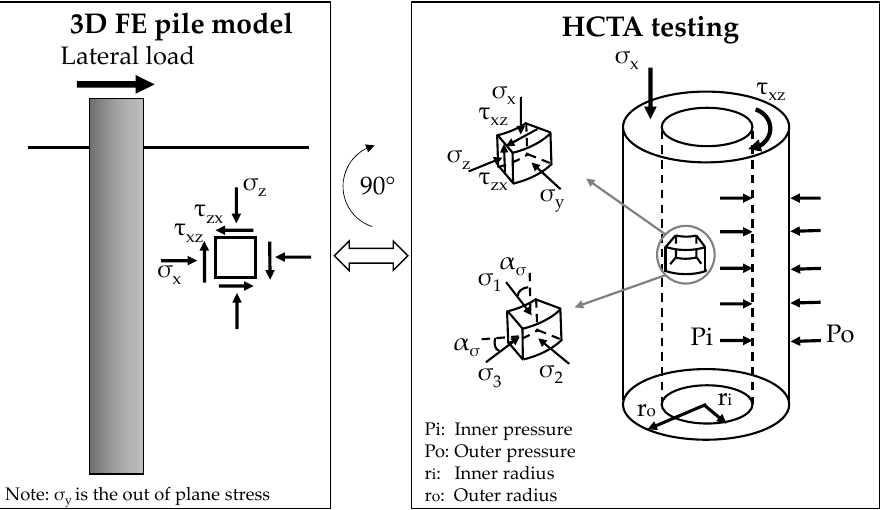
Figure 8. Simplified relationship between reference stress system in the finite element (FE) model and in hollow-cylinder torsional apparatus (HCTA).